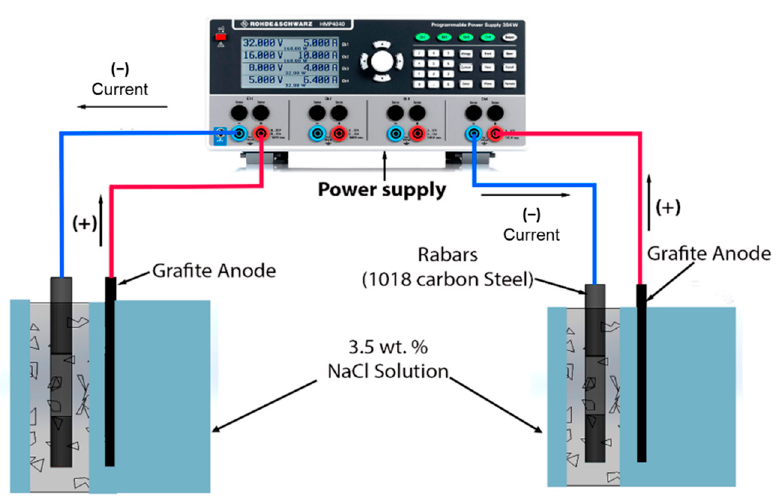
Figure 1. Experimental system to maintain the specimens under protection and cathodic overpro- tection.